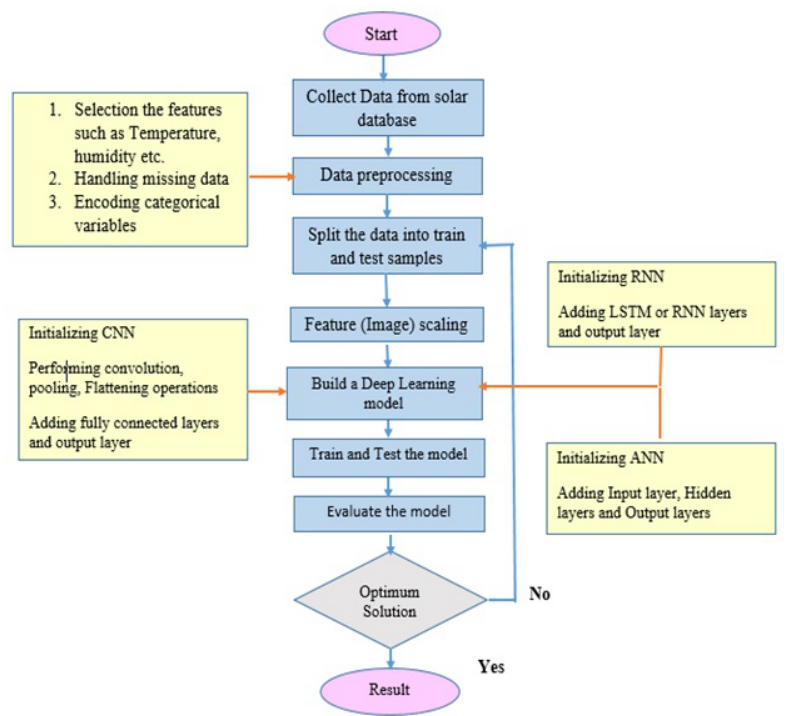
Figure 14. Flow chart for deep learning models.